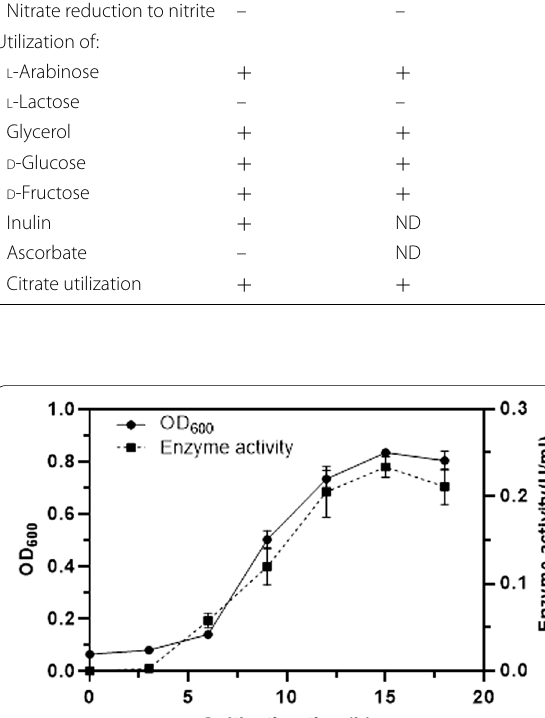
time, enzyme production increased parallel to the log phase. Maximum growth and enzyme production were observed after 12–15 h incubation.